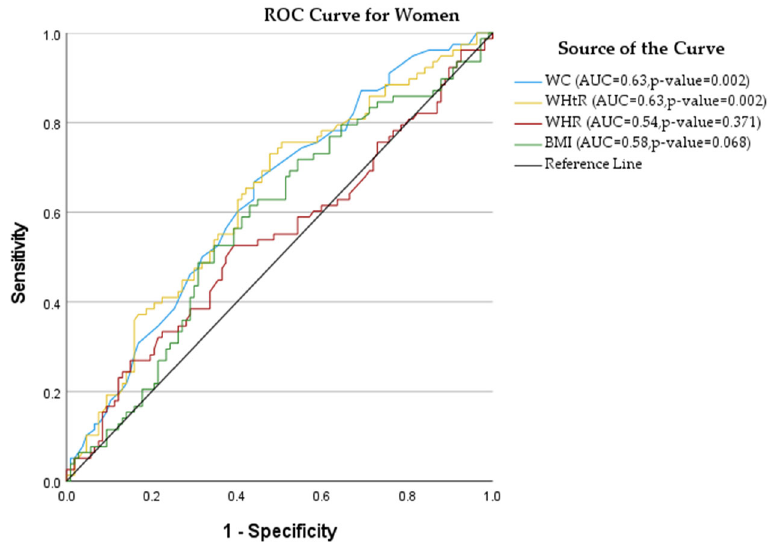
Figure 3. ROC curves for women presenting the relationship between obesity indicators and elevated SBP ( ≥ 140 mmHg).